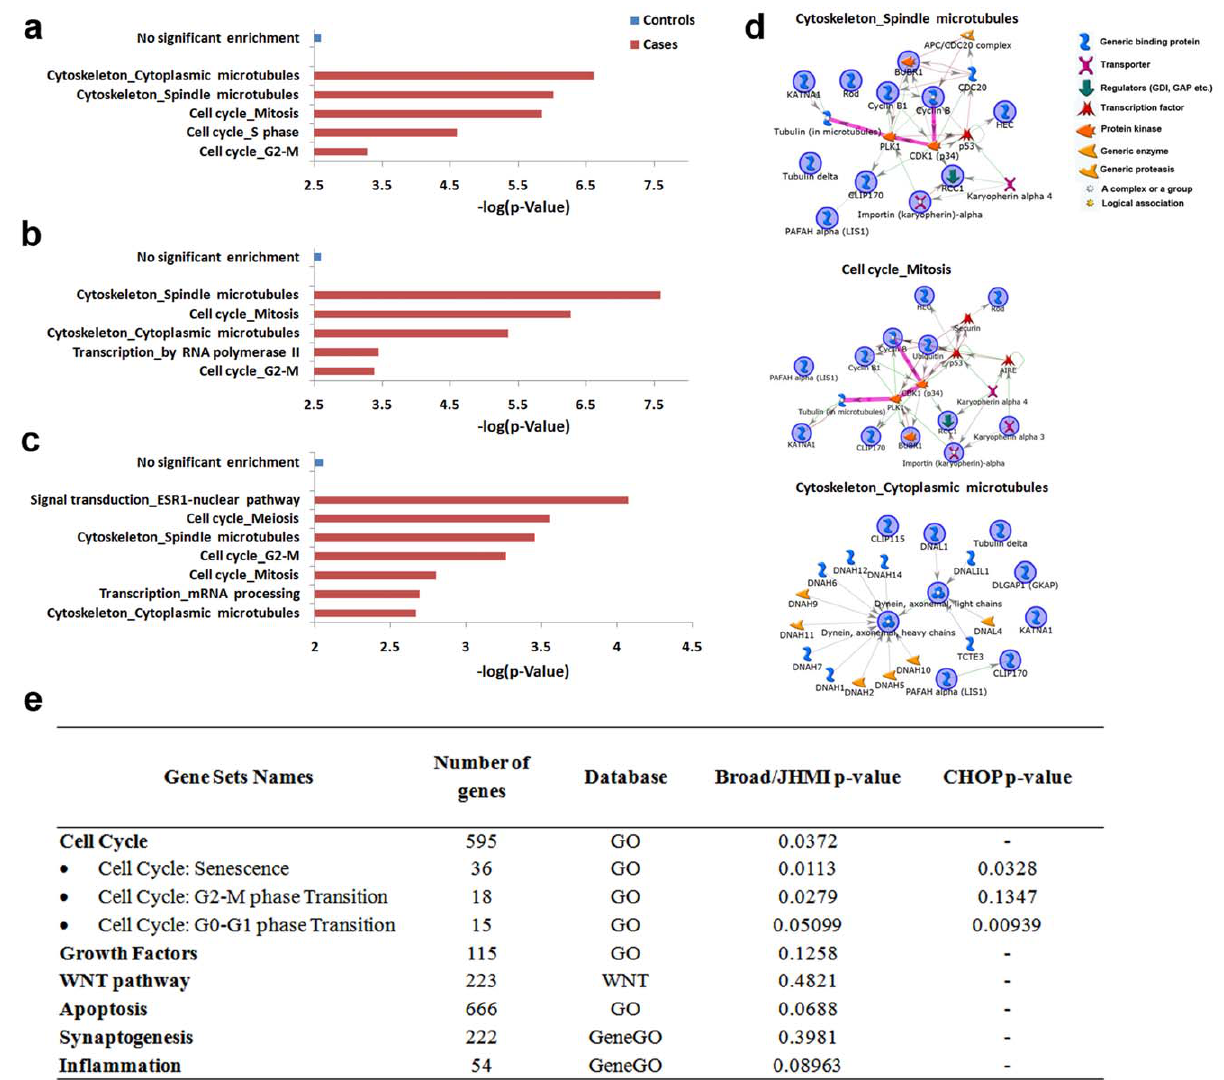
Figure 4. MetaCore process networks and network maps in autism based on gene deletions located in CNVs from DLPFC, and genetic association results. Autistic cases had significant enrichment of MetaCore process networks in genes contained within total CNVs (A) and filtered CNVs (i.e., not present in the Database of Genomic Variants) using PennCNV (B) and CNVision (C). Blue bars=controls; red bars=autistic cases. (D) MetaCore network analysis of the top three enriched MetaCore process networks in (B). Symbols in (D) represent gene types or associations. Genes with blue circles were identified autistic CNVs; genes without circles were summoned by the database to complete network. Pink lines=canonical pathway connections. (E) Gene sets tested in set-based association analysis using PLINK in Broad/JHMI and CHOP datasets, number of genes in each set, database from which genes were taken and p-values of associations.